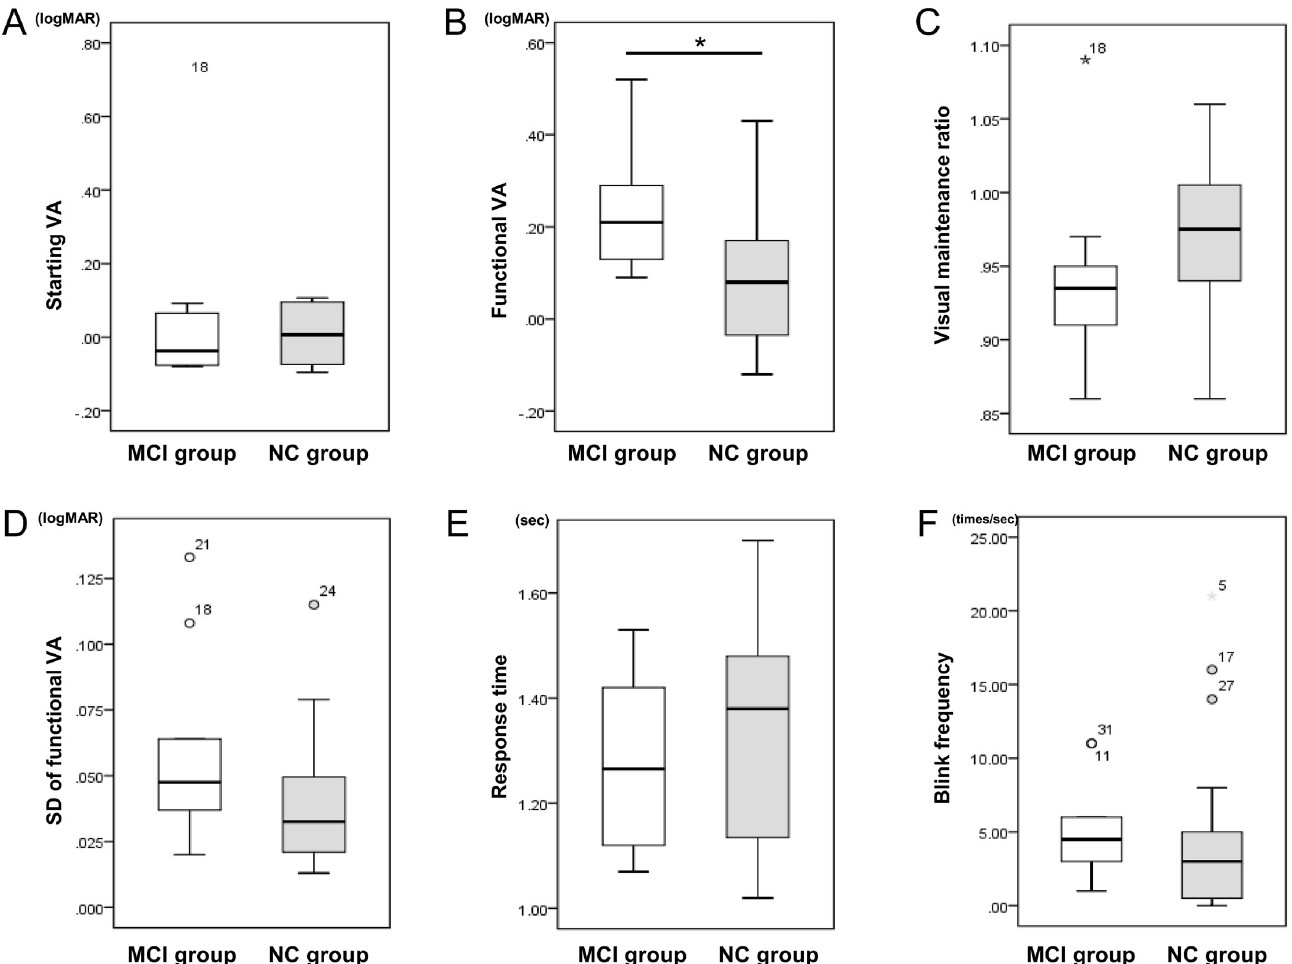
Fig 3. Distributions of functional visual acuity parameters in the MCI and NC groups. Distribution of starting visual acuity (A), functional visual acuity (B), visual maintenance ratio (C), SD of functional visual acuity (D), response time (E), and blink frequency (F). logMAR, logarithm of the minimum angle of resolution; MCI, mild cognitive impairment; NC, normal cognition; SD, standard deviation; VA, visual acuity.